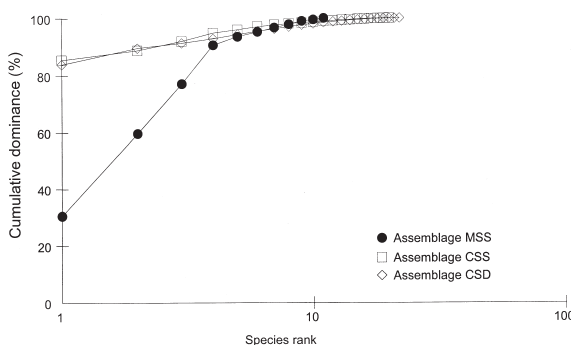
Fig . 3. – Cumulative dominance curves in number of individuals for the three assemblages identified by cluster analysis. MSS (Medium Sand Shallow), CSS (Coarse Sand Shallow) and CSD (Coarse Sand Deep).